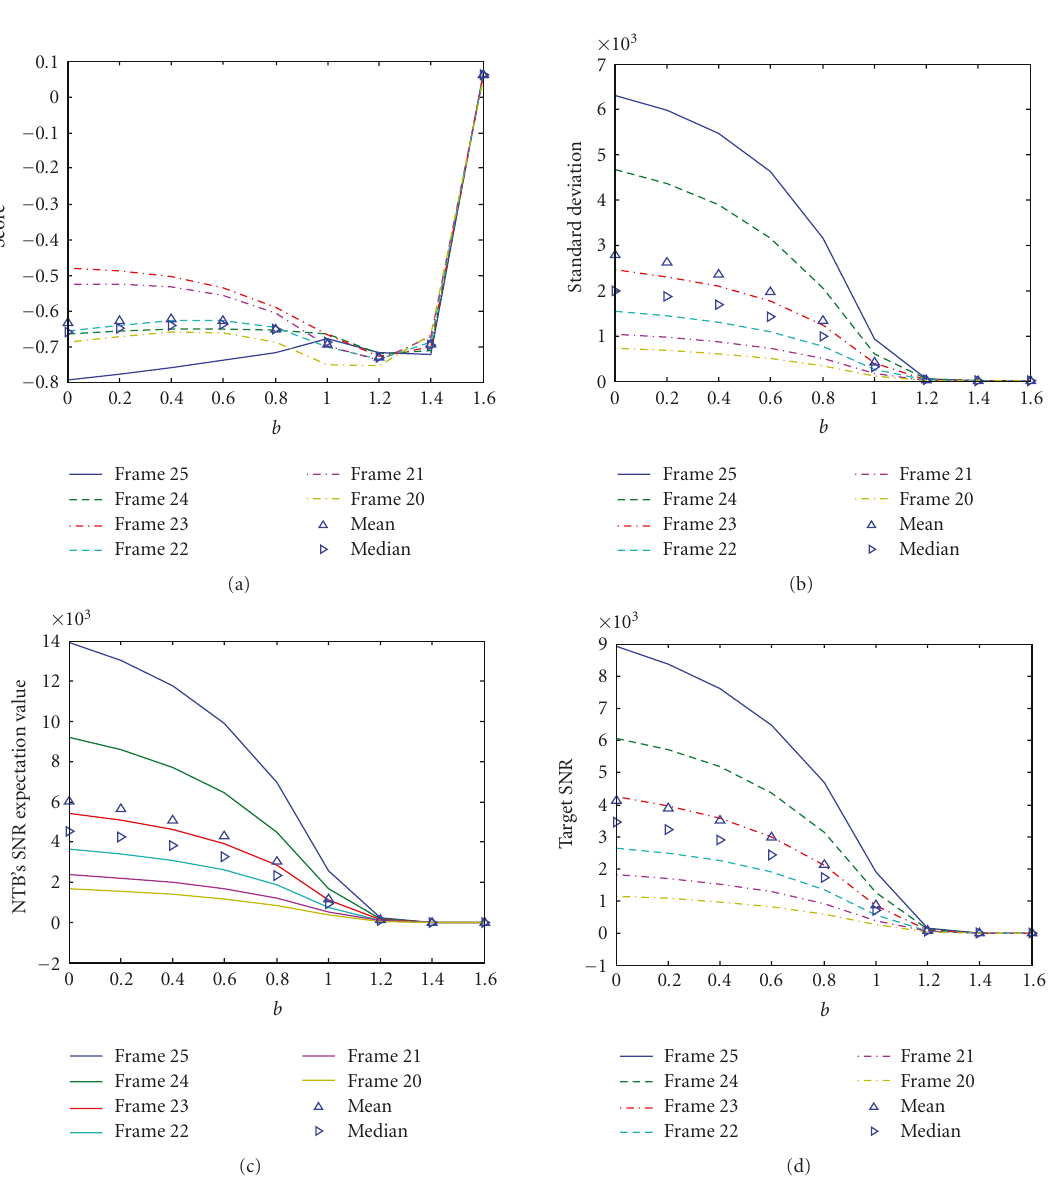
Figure 24: NPA sequence, s n = 3. (a) A S, g = 1, Max Numbers = 1, (b) standard deviation of NTB’s SNR, (c) expectation value of NTB’s SNR, and (d) TB’s